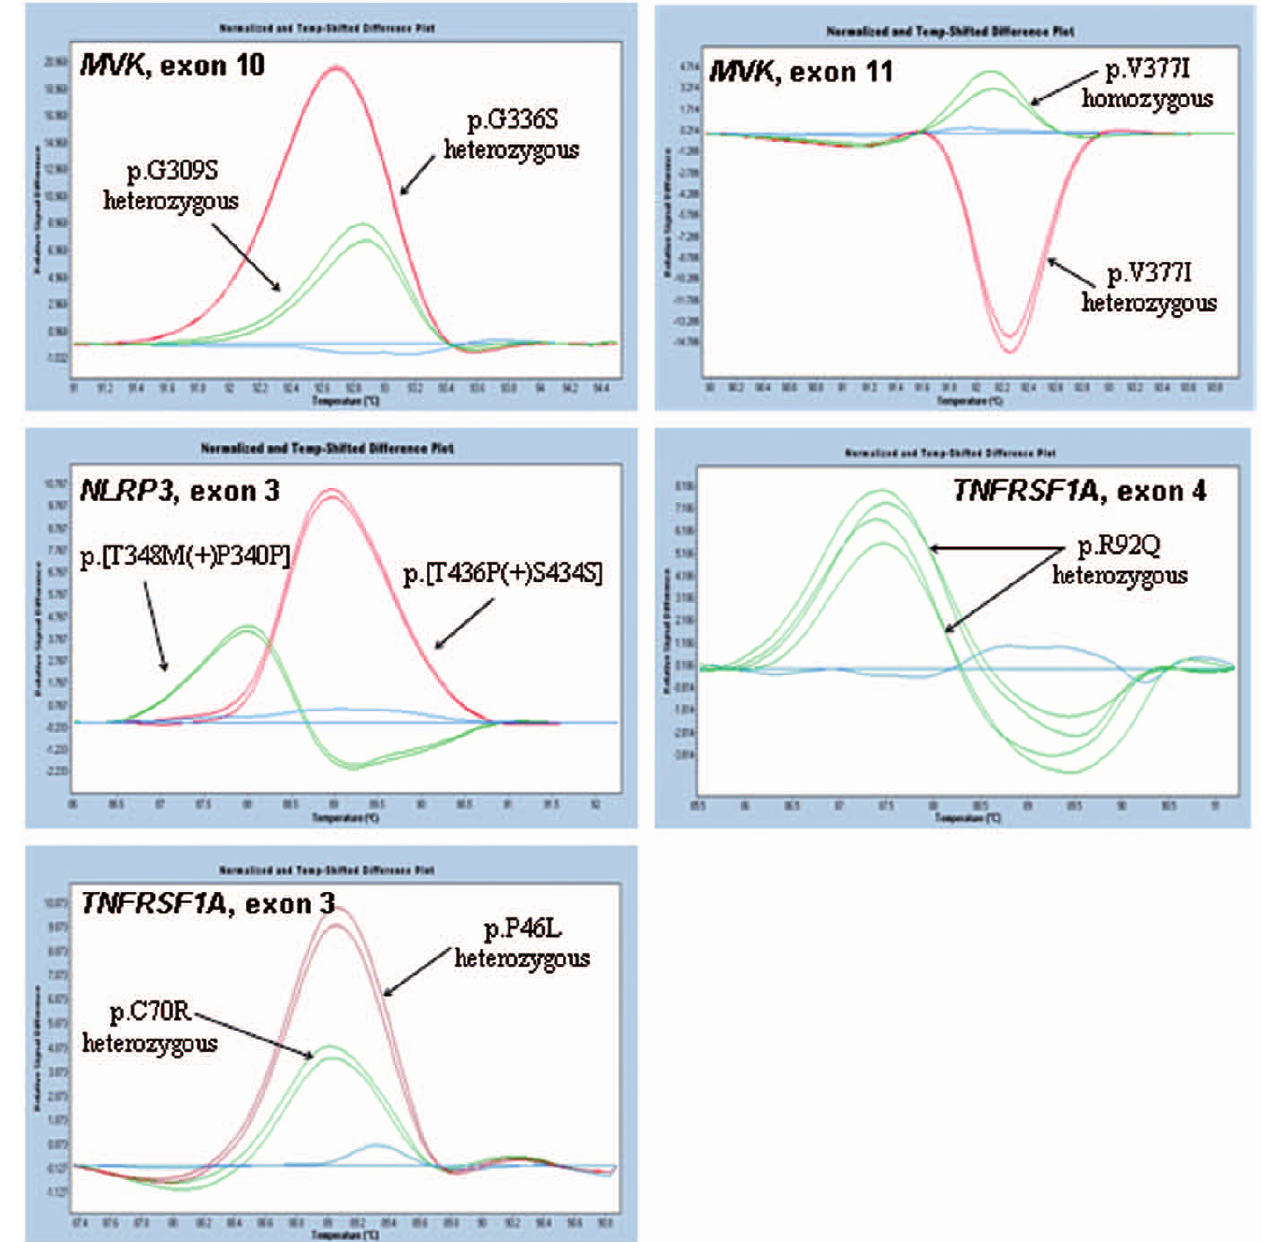
Figure 3. Pathological genotypes detected by qPCR-HRM in the prospective study. Qualitative changes were assessed using the gene scanning module of the LightCycler 480 Software version 1.5. Wild type sequences were used to define baselines. Difference plots revealed disease associated variants.